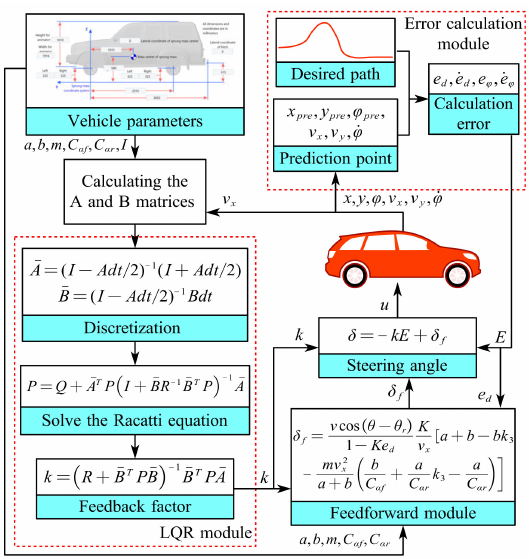
Figure 4. The structure of the LQR control